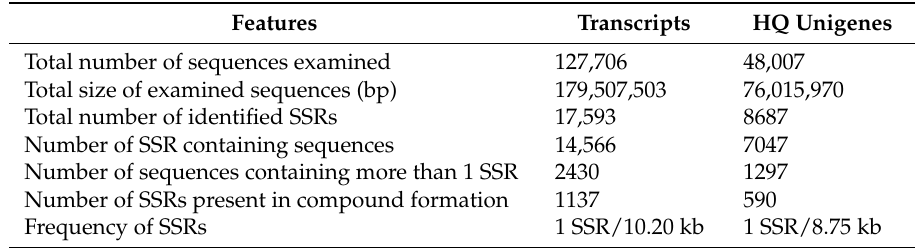
Table 3. Statistics of simple sequence sepeats (SSRs) identified by